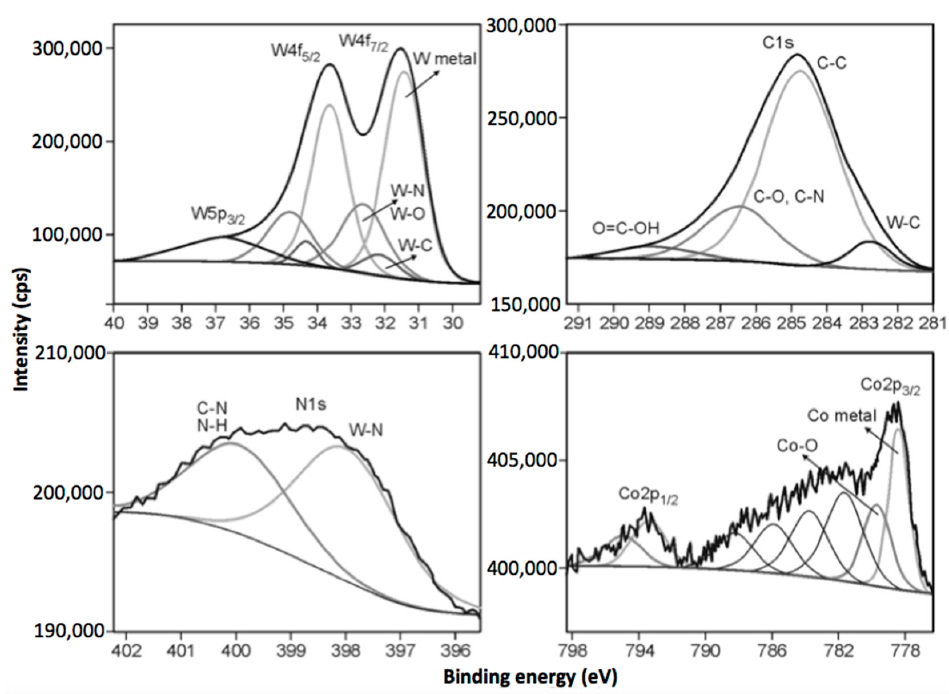
Figure 5. High ‐ resolution XPS spectra of W4f (upper left), C1s (upper right), N1s (lower left) and Co2p (lower right) of the Figure 5. High-resolution XPS spectra of W4f ( upper left ), C1s ( upper right ), N1s ( lower left ) and Co2p ( lower right ) of nitrogen implanted guide pads (3 × 10 17 cm − 2 ). the nitrogen implanted guide pads (3 × 10 17 cm − 2